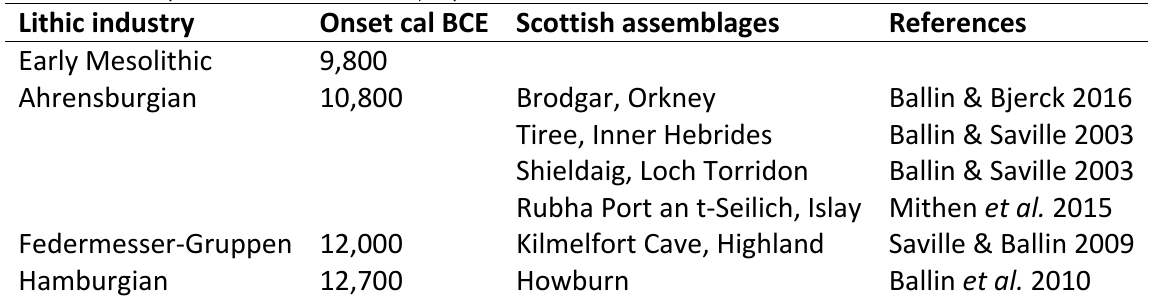
Table 1. The lithic industries identified in Scotland and sites mentioned in the text. Dates largely according to Sonia Grimm (personal communication, September